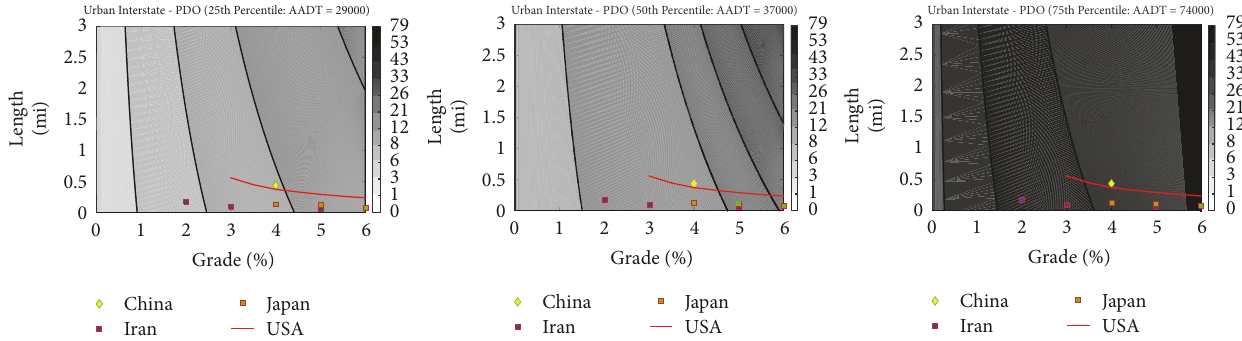
Figure 10: Prediction of urban interstate PDO crash